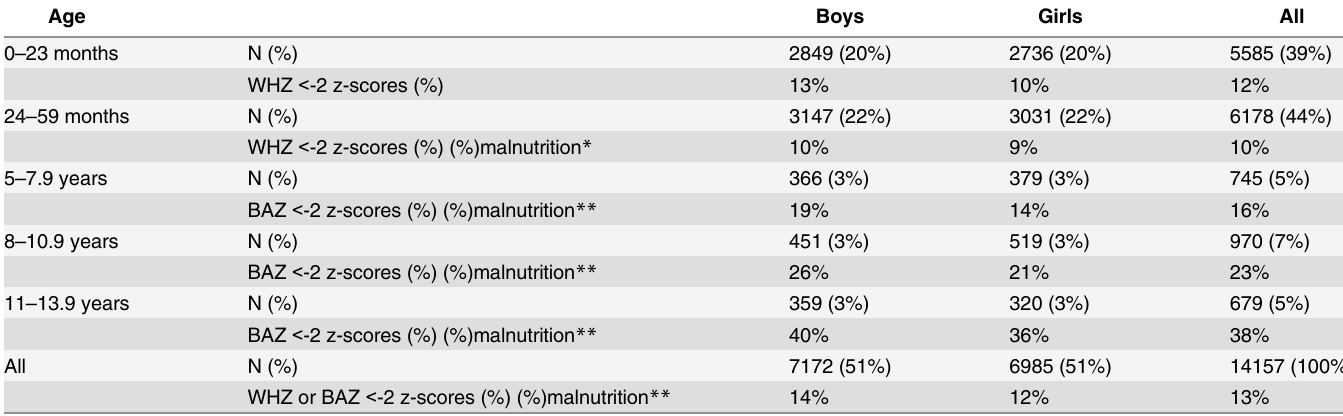
Table 1. Age and gender characteristics of the participants and proportion of children suffering from acute malnutrition. Age Boys Girls